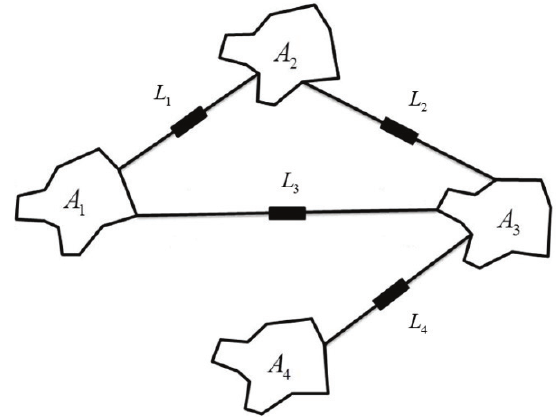
Figure 1. An interconnected local systems power system.